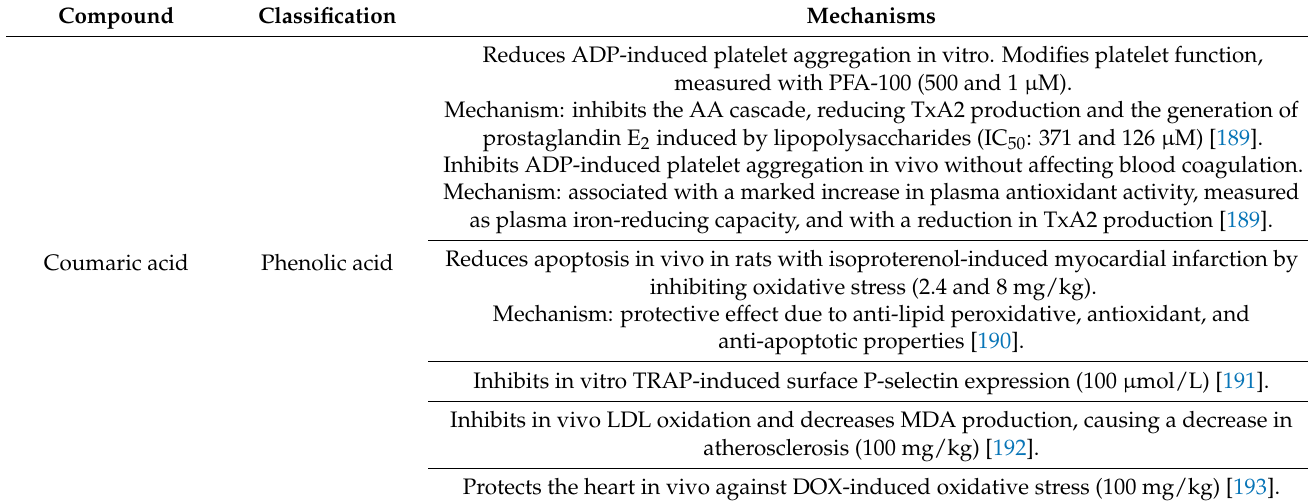
Table 1. Cardioprotective studies of bioactive compounds from Phaseolus vulgaris